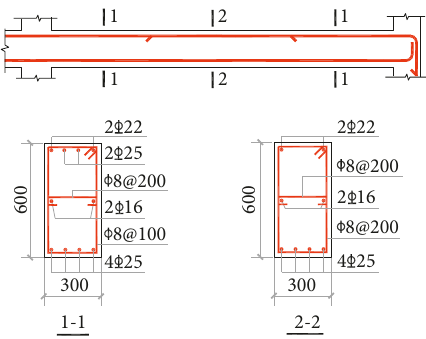
Figure 1: Picture of strengthening “angle steel and batten plate.”